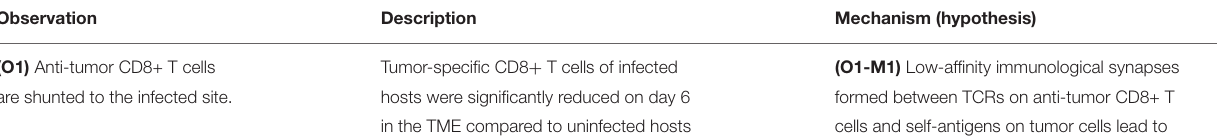
TABLE 1 | A summary of the immunological reconstruction of infection-tumor interactions a .